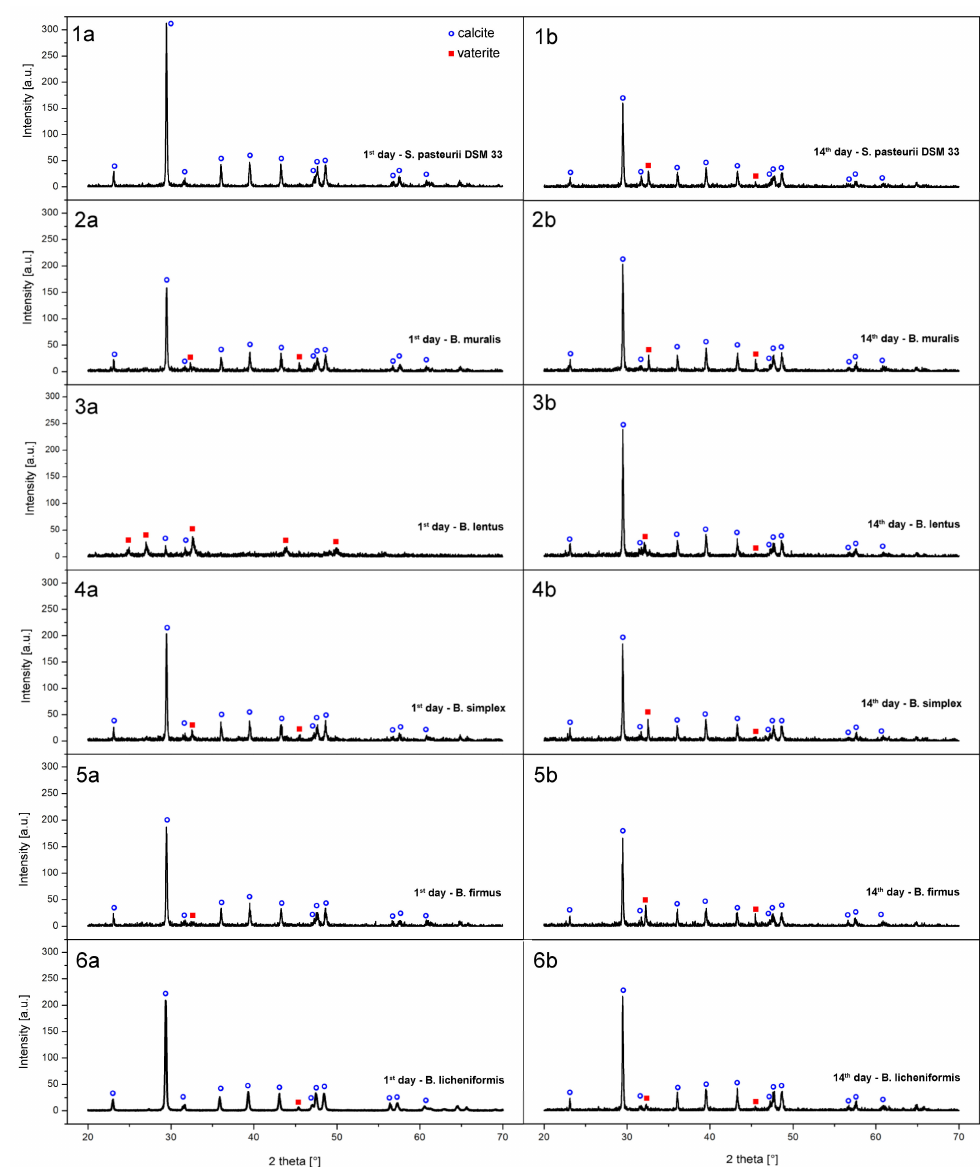
Figure 7. XRD spectra of CaCO 3 precipitates (a—1st day; b—14th day; 1— S. pasteurii DSM 33; 2— B. muralis ; 3— B. lentus ; 4— B. simplex ; 5— B. firmus ; 6— B. licheniformis